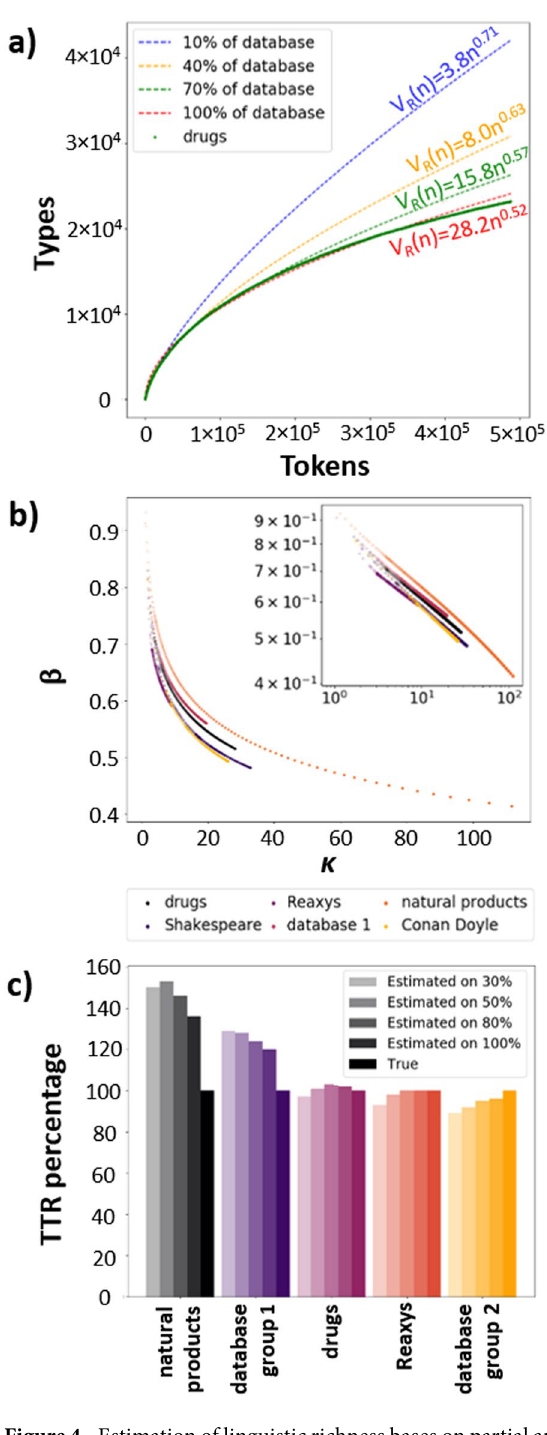
Figure 4. Estimation of linguistic richness bases on partial analyses of datasets and Heap’s law. ( a ) As progressively larger fractions of a particular collection/database (here, 1,000 drugs) are analyzed, the fits based on the Heap’s law, V R ( n ) = Kn β , converge to the type-token distribution characterizing the entire collection. ( b ) During such convergence, the exponents β decrease and prefactors K increase. The inset shows that this relationship is common to different molecular or literature collections – the straight lines on the doubly- logarithmic scale indicate a power law β ~ K −γ (note: similar slopes correspond to similar values of γ ). ( c ) Prediction of the type-token ratios, TTRs, based on the partial fits for different types of collections. The true value of the entire collection is taken as 100%. “Database group 1” and “database group 2” are the two families of Mcule databases from Fig. 3. The largest discrepancy between fits and real diversity is observed for natural products whose linguistic peculiarity is also manifest in our other analyses (cf. Figure 2b where the natural- products curve intersects dependencies for drugs and Reaxys molecules). For other collections, estimating 30–50% of the content already gives decent estimates of their actual